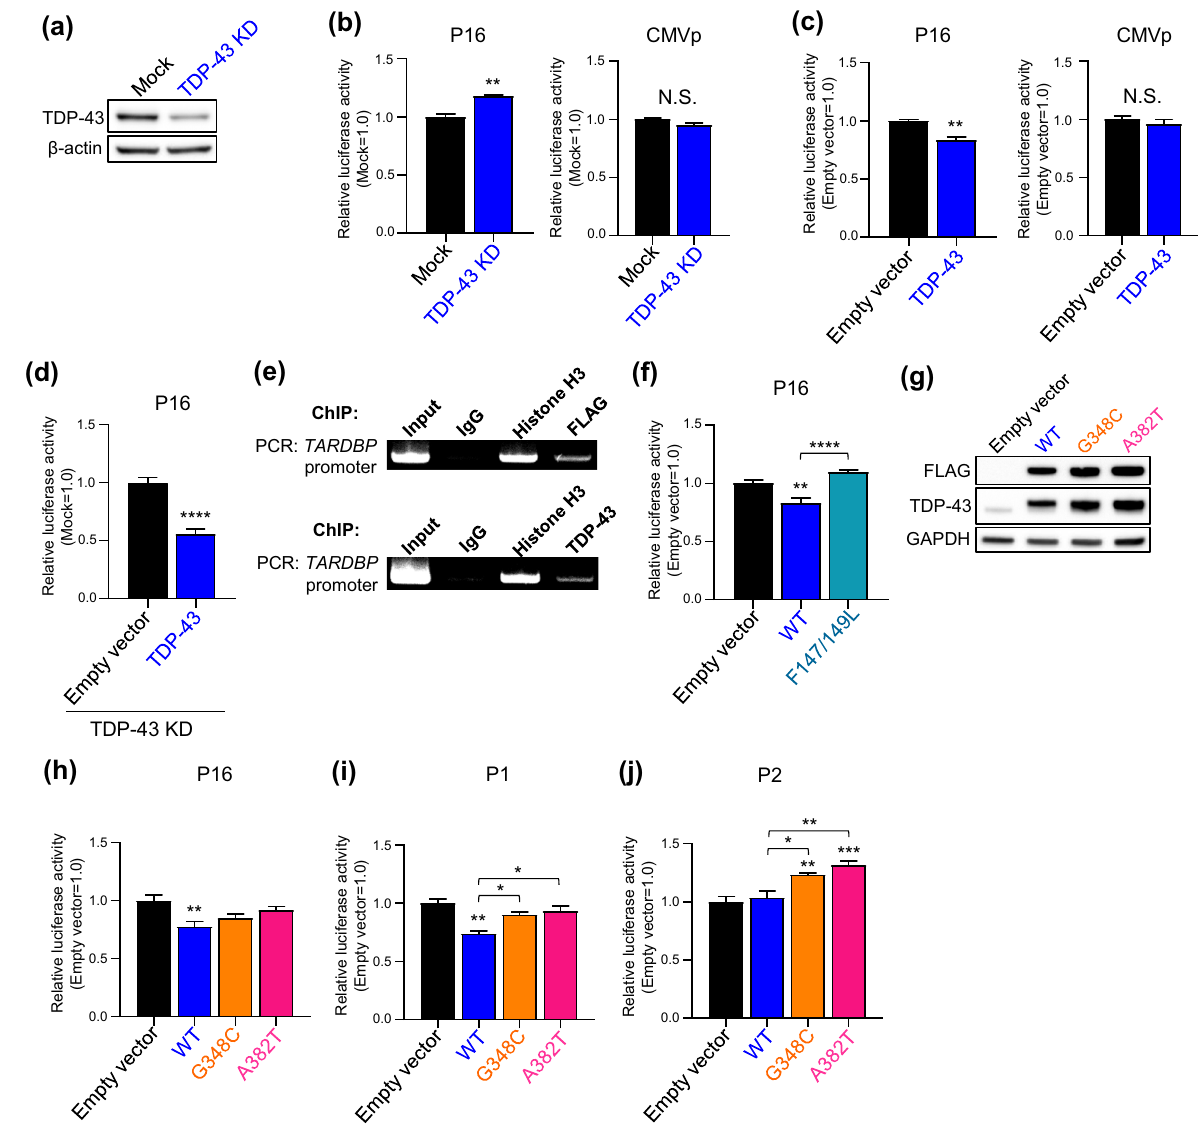
Figure 5. TDP-43 regulates the activity of the TARDBP upstream and intron 1 promoter. ( a ) Immunoblot analysis of TDP-43 in HeLaS3 cells. Mock and KD indicate transfected negative control or TDP-43 siRNA, respectively. ( b-d ) Luciferase assay of P16 or CMV promoter activity with TDP-43 KD ( b ) or overexpression ( c ) or both endogenous TDP-43 KD and exogenous TDP-43 overexpression ( d ). n = 4 ( b, c ) and n = 8 ( d ) replicates; Welch’s t-test relative to Mock ( b ) or Empty vector ( c , d ). ( e ) ChIP assay of overexpressed FLAG-TDP-43 ( top ) or endogenous TDP-43 ( bottom ) binding to the TARDBP promoter in HEK293T cells. Immunoprecipitation was performed using anti-DDDDK (FLAG) antibody (for overexpressed FLAG-TDP-43) or anti-TDP-43 antibody (for endogenous TDP-43), then PCR was conducted using primer detecting TARDBP -721 to -431 (290 bp). Control IgG and Histone H3 antibody are used for negative or positive control for immunoprecipitation. ( f ) Luciferase assay of P16 promoter activity with RRM1 mutant TDP-43 (F147/149L) overexpression. n = 8 replicates; one-way ANOVA with post hoc Tukey’s test. ( g ) Immunoblot analysis of FLAG-WT or 2 pathological TDP-43 mutants (G348C or A382T) overexpressed in HeLaS3 cells. Empty vector was transfected as the negative control. ( h-j ) Luciferase assay of P16 ( h ), P1 (upstream promoter) ( i ) and P2 (intron 1 promoter) ( j ) promoter activity with overexpression of WT TDP-43 or 2 pathological TDP-43 mutants (G348C or A382T). n = 7 ( h ), n = 3 ( i ) and n = 5 ( j ) replicates; one-way ANOVA with post hoc Tukey’s test. 2 μg of each reporter plasmids (P16, P1 and P2) were co-transfected with 1 μg of TDP-43/pFLAG-CMV2 in all overexpression experiments. Empty vector was used as the control in the overexpression experiment. All error bars indicate the means ± SEMs. * P < 0.05, ** P < 0.01, *** P < 0.001, **** P <